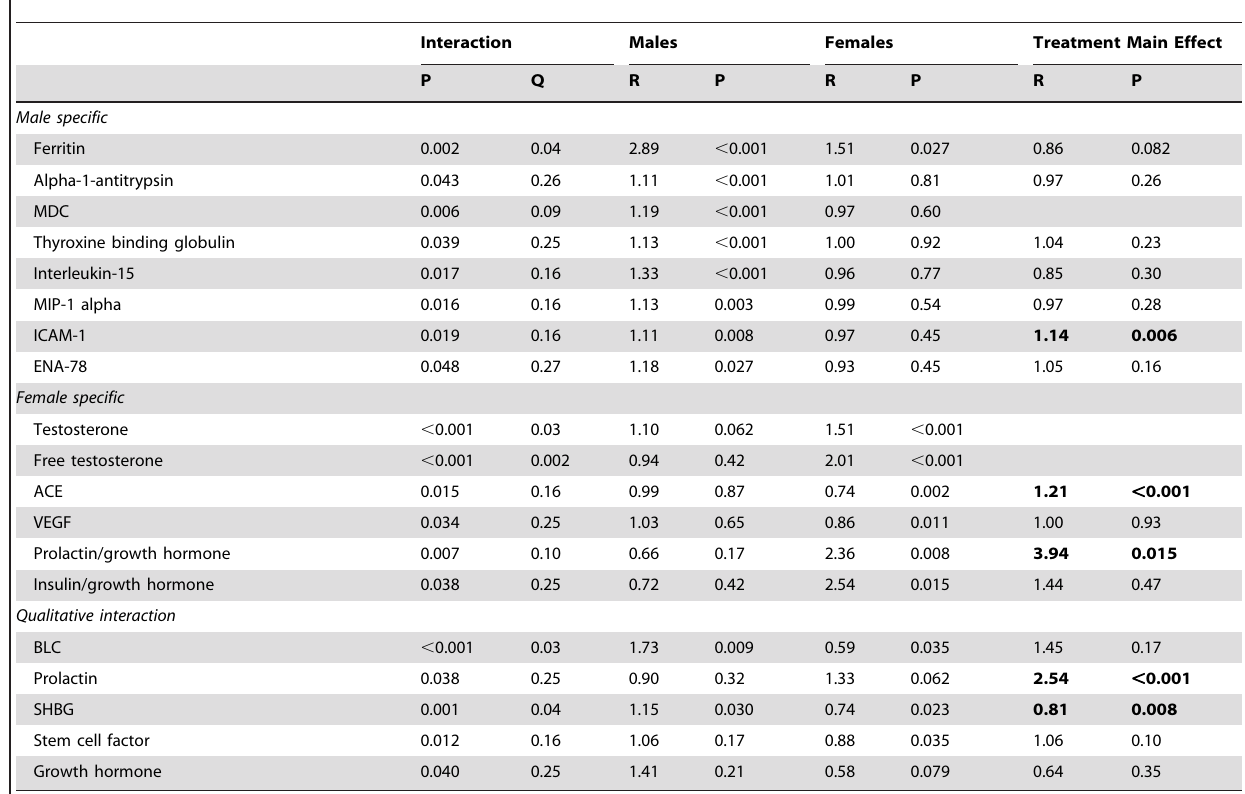
Table 4. Summary of significant diagnosis-sex interactions in schizophrenia and treatment effects on the levels of analytes.